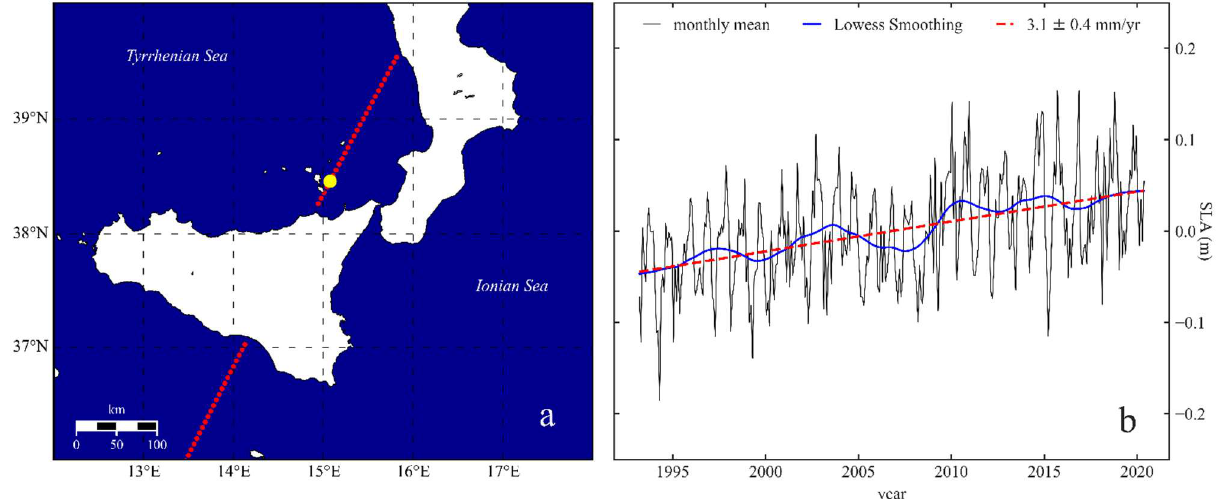
Figure 3. ( a ) Location of track 059 (red dotted line) of X-TRACK across southern Tyrrhenian Sea; the yellow dot highlights the position of the data considered in this work; ( b ) monthly mean SLA time series (black) with linear trend (red) and superimposed Lowess smoothing (blue).